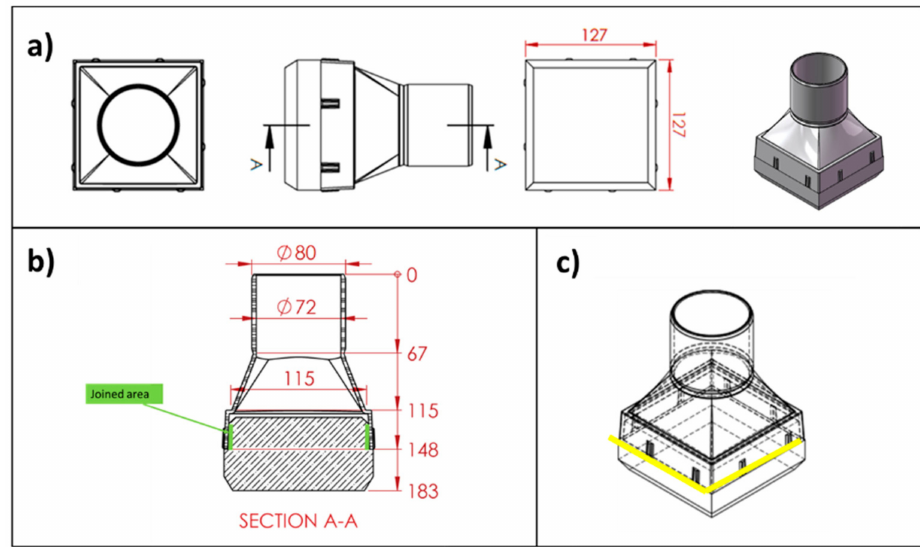
Figure 3. Sketch of cup/foam joint; ( a ) the tile and the Venturi-shaped cup; ( b ) section A-A: joined areas are indicated in green colour; ( c ) schematic of possible joining design on two sides of the cup (yellow colour) instead of four. Dimensions are in